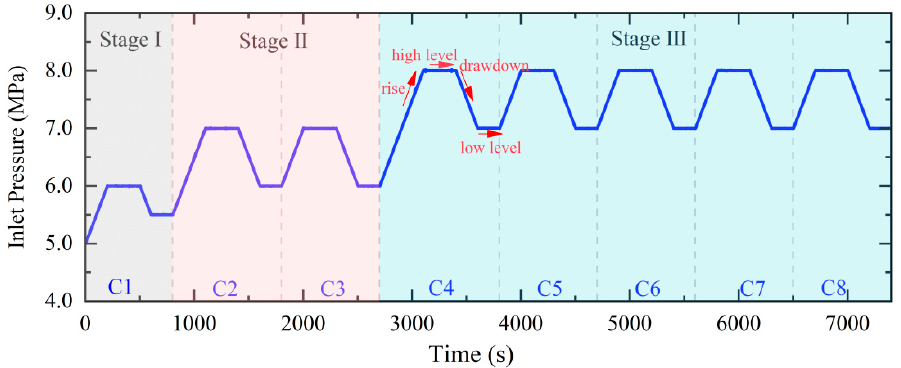
Figure 4. A schematic of the cyclic pressurization process.